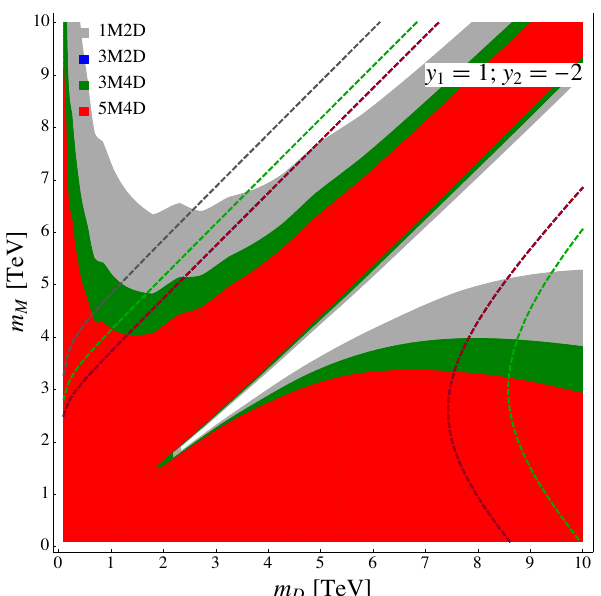
Figure 11. Tree-level DM-nucleon SI scattering in the plane m D m M for all the models considered (cid:0) in this work. Colored regions are excluded by prospects of limits from the XENON1T experiment [9] for y 1 = 1 and y 2 = 2. Colored lines show contours of DM composition, the lower right ones denote (cid:0) 2 = 0 : 999 while the upper left ones correspond to 2 = 0 : 001. The contours of the 3 Z M Z M 11 j 11 j j j model overlap with those of the 5 4 M D